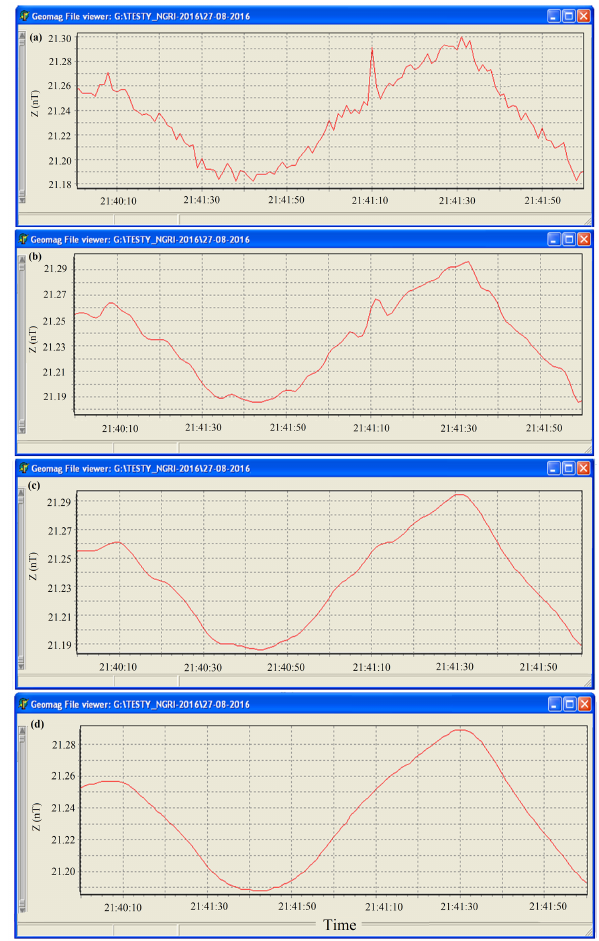
Figure 6. Application of LPF-GEOMAG software showing de- trending of the observed spike at 21:41:10UT on 27 August 2016: (a) without use of filter (spike amplitude: 0.045nT), (b) with a cut- off frequency of 0.2Hz (spike amplitude: 0.023nT), (c) with a cut- off frequency of 0.1Hz (spike amplitude: 0.01nT) and (d) with a cutoff frequency of 0.05Hz (spike amplitude: